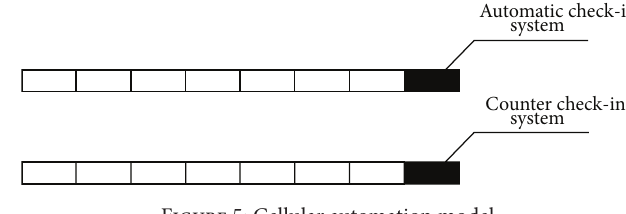
Figure 5: Cellular automation model.